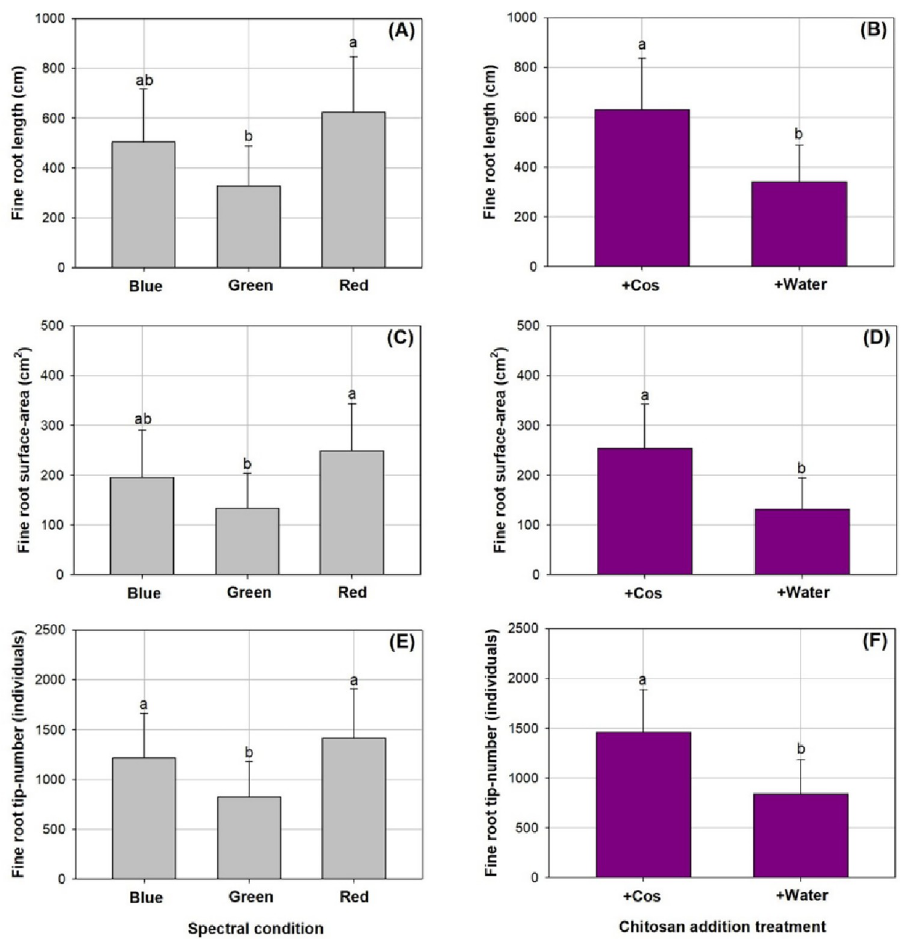
Fig 3. Fine root length (A and B), surface-area (C and D), and tip-number (E and F) in Podocarpus macrophyllus seedlings exposed to main effects of chitosan (+Cos) and water (+Water) sprays and the variation among three types of light emitting diodes spectra in red, green, and blue lights. Bar height corresponds to the mean of the measurement while the error bars represent standard errors. Different letters represent difference at significant level of 0.05 by Tukey